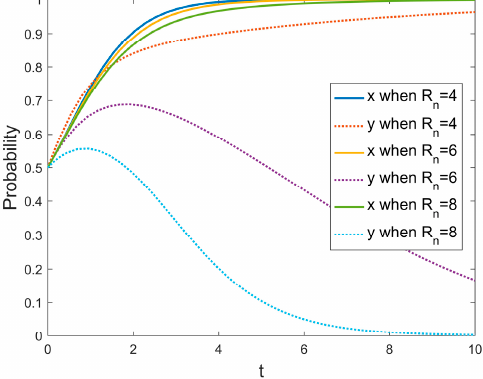
Figure 5. The impact of the benefits of herders when they are completely dependent on non-grazing livelihoods in the evolutionary game.